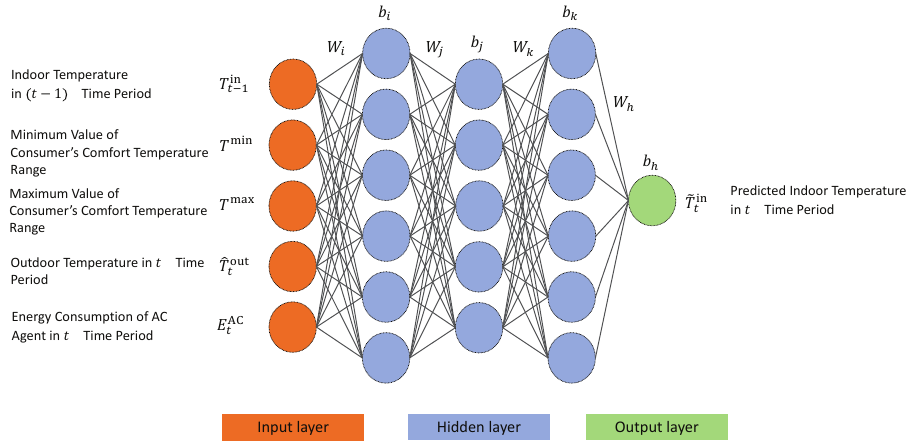
Figure 3. Architecture of the proposed artificial neural network (ANN)